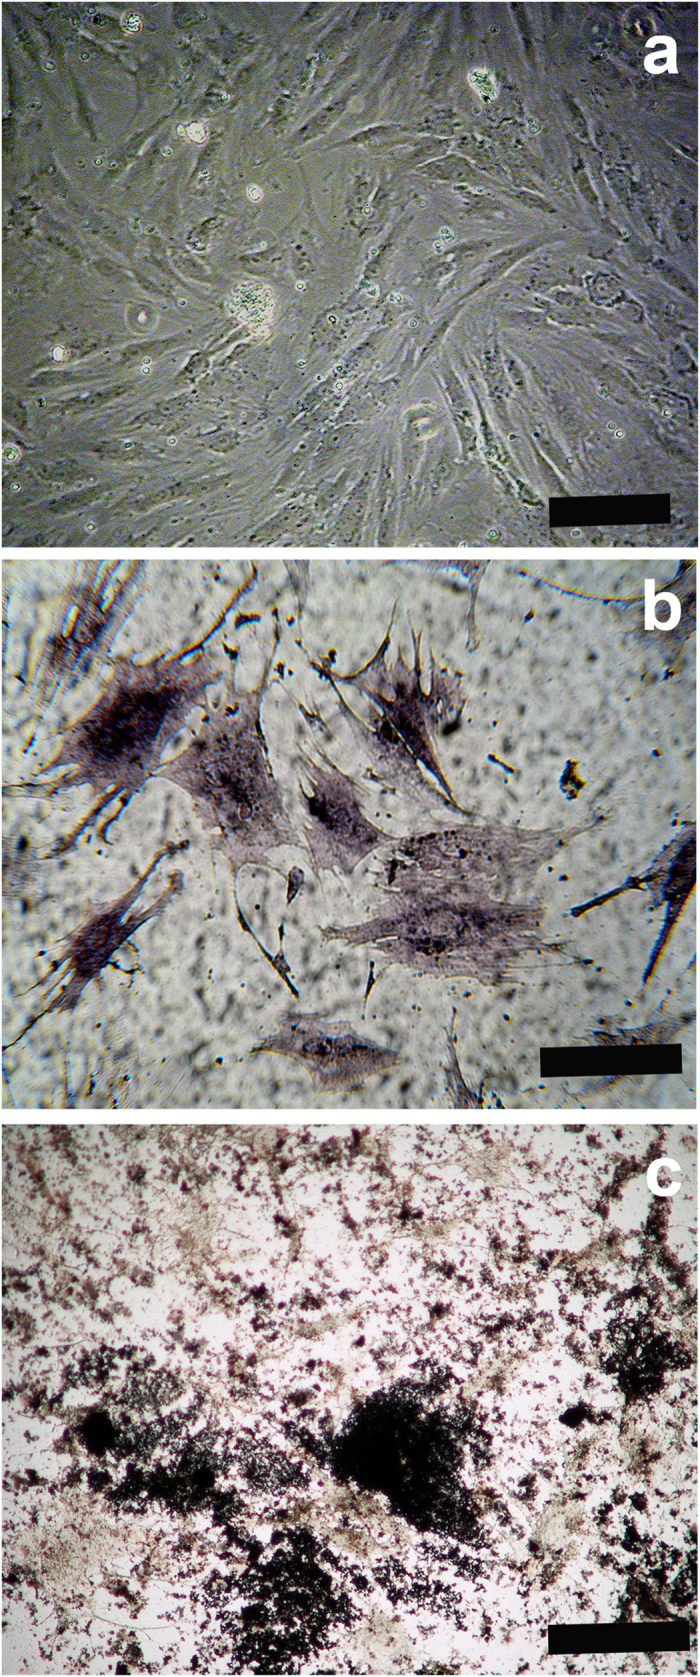
(a) Fibroblast-like morphology of PDPCs observed in phase contrast, (b) Osteogenic differentiation of PDPCs assessed by ALP staining, and (c) identification of CaPO4 crystals by Von Kossa reaction. Scale bars: (a) 10 μm; (b) and (c) 20 μm.